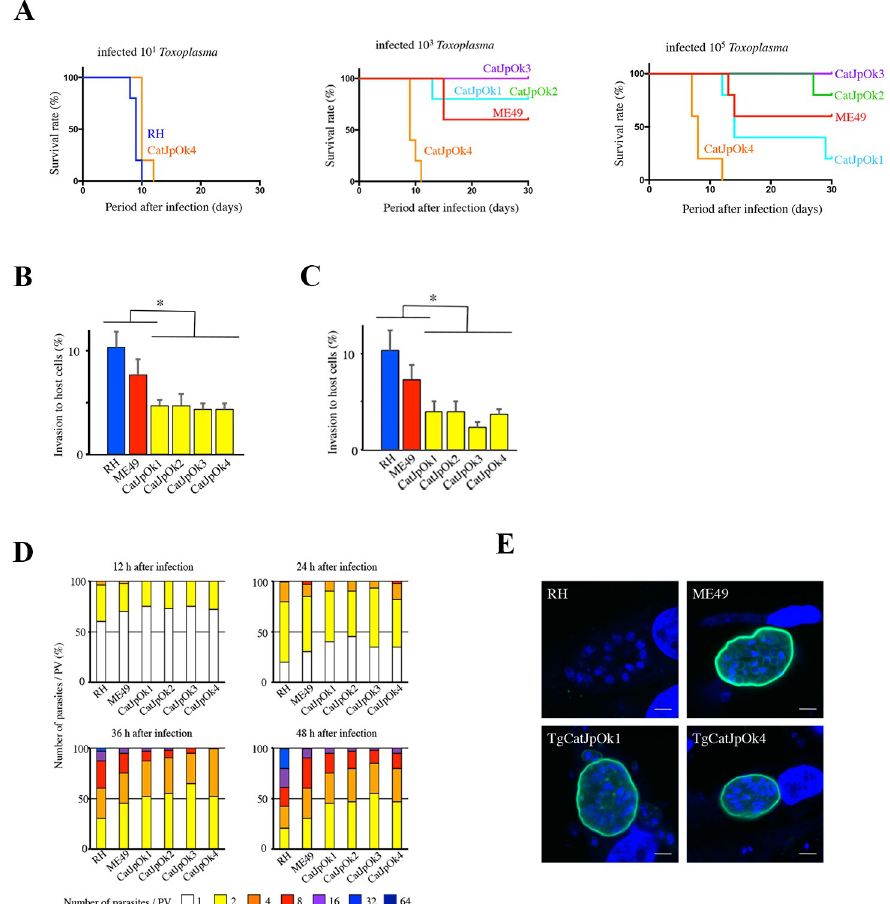
Fig 3. Virulence phenotypes of Japanese isolates of T . gondii . (A) Survival rates following intraperitoneal inoculation of 10 1 , 10 3 and 10 5 parasites in mice (n = 5 in each group). Survival was monitored for 30 days after inoculation. (B, C) Rates of invasion of host cells (B, HFFs; C, mouse embryonic fibroblasts (MEFs)) for 30 min after inoculation with a virulent haplogroup 1 strain (RH), low virulent haplogroup 2 strain (ME49), and Japanese isolates. Values are shown as mean + SEM, n = 3, � p < 0.05, Tukey-Kramer test. (D) Proliferative rates in HFFs infected with RH, ME49 and Japanese isolates determined by counting the number of parasites in parasitophorous vacuoles (n = 3). (E) Tissue cyst formation by RH, ME49, TgCatJpOk1 and TgCatJpOk4. The tissue cyst wall was stained by FITC-conjugated Dolichos biflorus agglutinin and is shown in green. Nuclei were stained with DAPI and are shown in blue. Scale bars = 5 μ m.